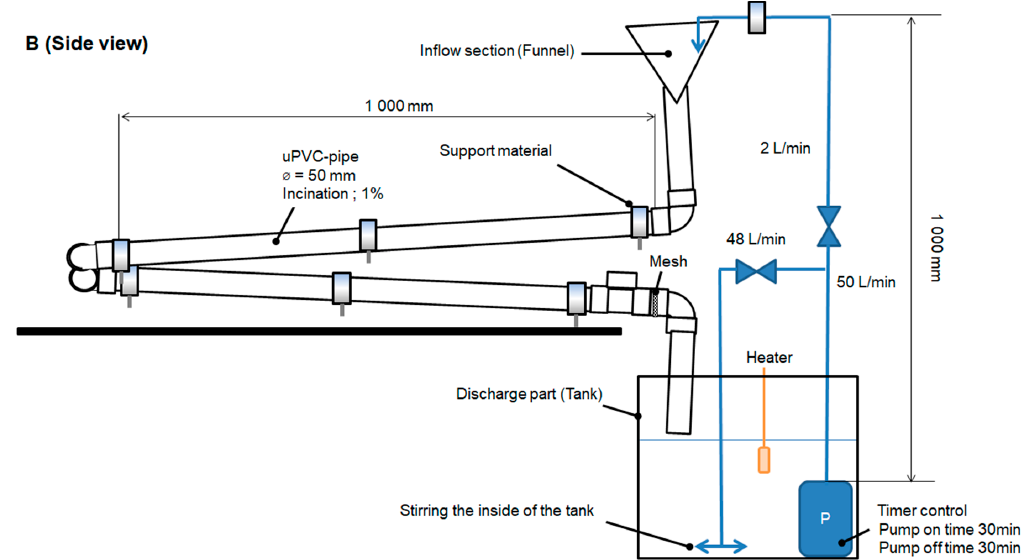
Figure 2. Outline of the equipment for simulated experiment to elucidate blockage mechanism in the sewer pipe: ( A ) top view and ( B ) side view.